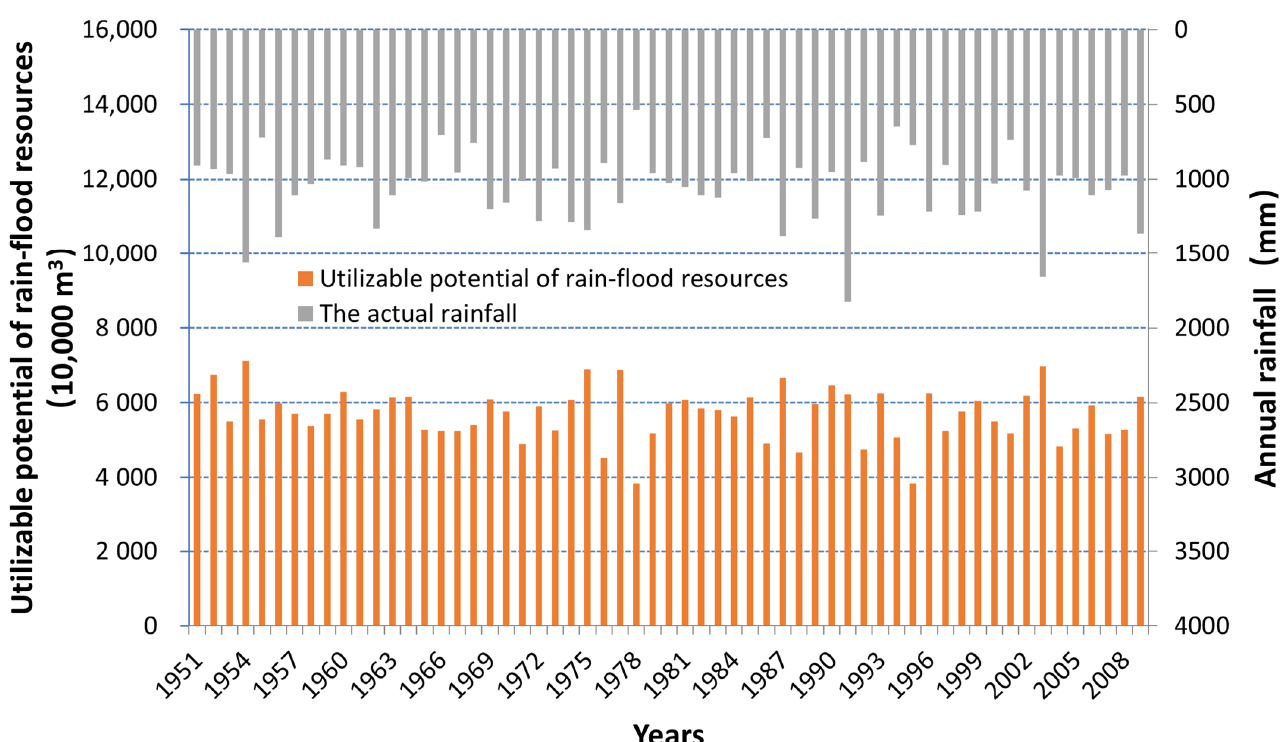
Water 2021 , 13 , 2791 Figure 4. The annual rainfall and utilizable potential of rain–flood resources in Gucheng Lake catchment area. Figure 4. The annual rainfall and utilizable potential of rain−flood resources in Gucheng Lake catchment area.